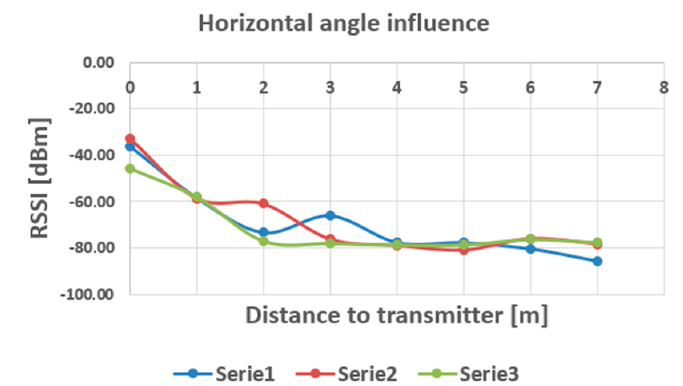
Figure 15. Influence of horizontal position on the RSSI readings (Serie 1—H = 0 o , Serie 2—H = 45 o , Serie 3—H = 90 o ).